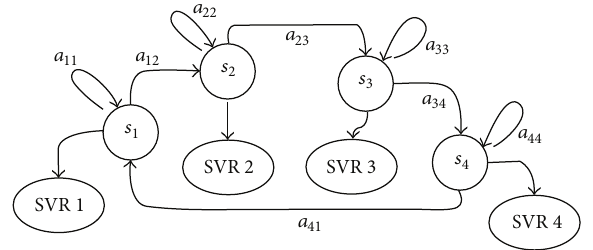
Figure 10: Topology of the hybrid SVR/Markov. Four states decide which of the present SVR to be used according to the historical data. Table 5: Solar radiation prediction results for a four- state MARM. Filter order ( 𝑝 ) 2 3 5 Prediction horizon/min 1